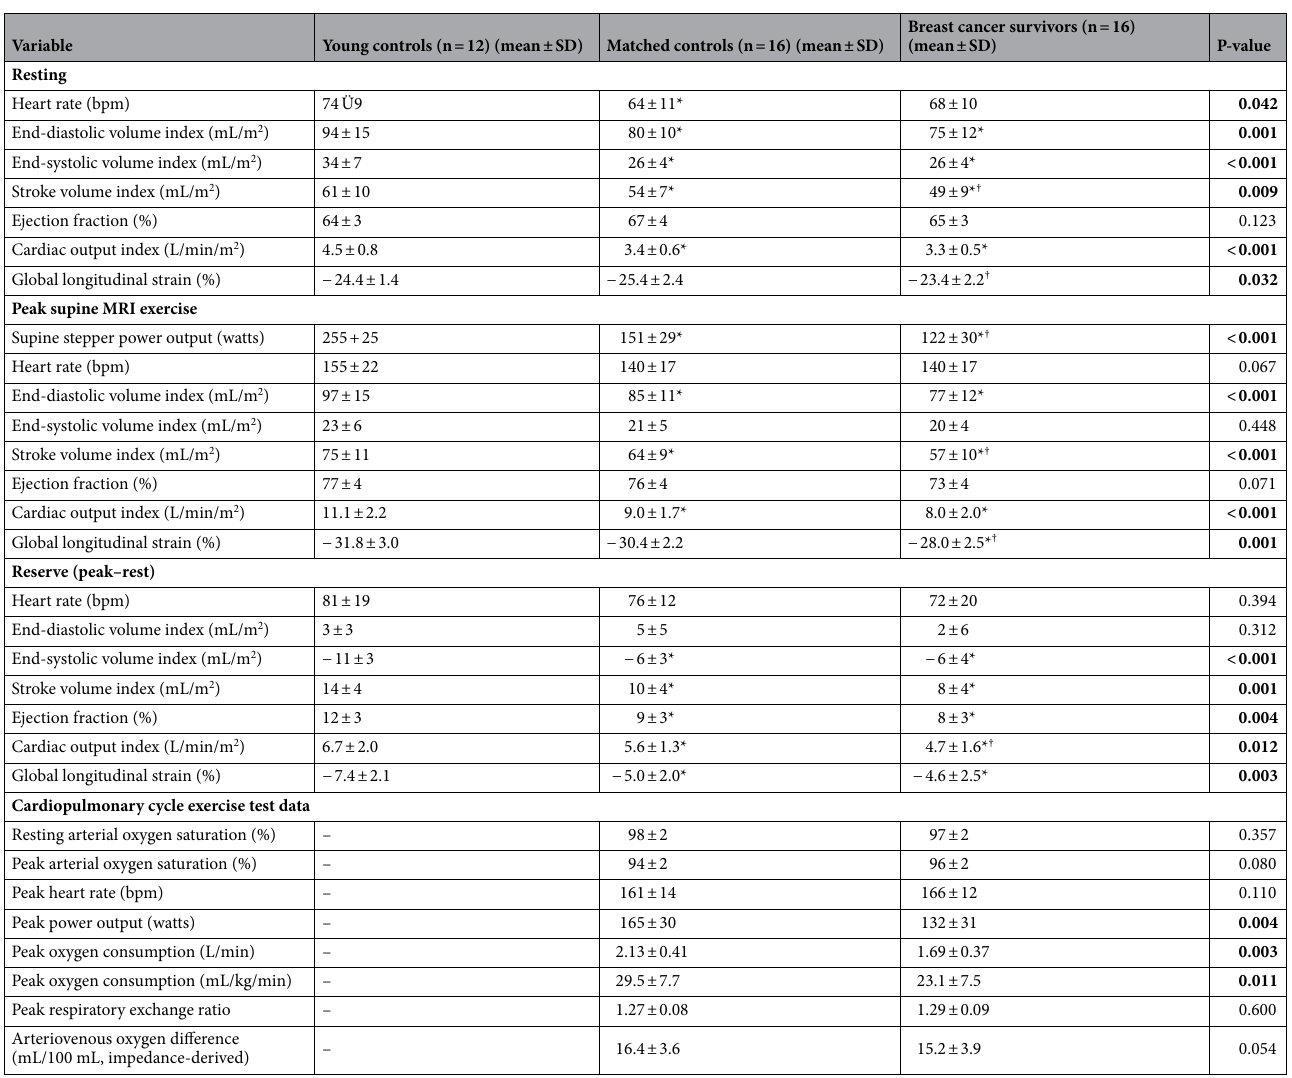
Table 2. Cardiac magnetic resonance and cardiopulmonary data. *Statistically different from young controls at p ≤ 0.05; † Statistically different from matched controls at p ≤ 0.05;– denotes data not collected in this